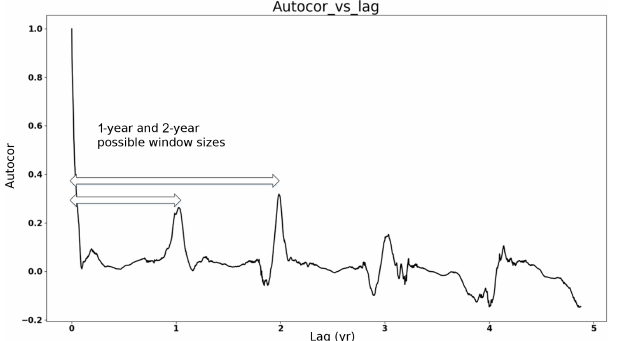
Figure 7. Case Study 1, training data DS vs. window size: 1-year DS is less than 2-year DS. This means the 1-year window contains more stable data and should be